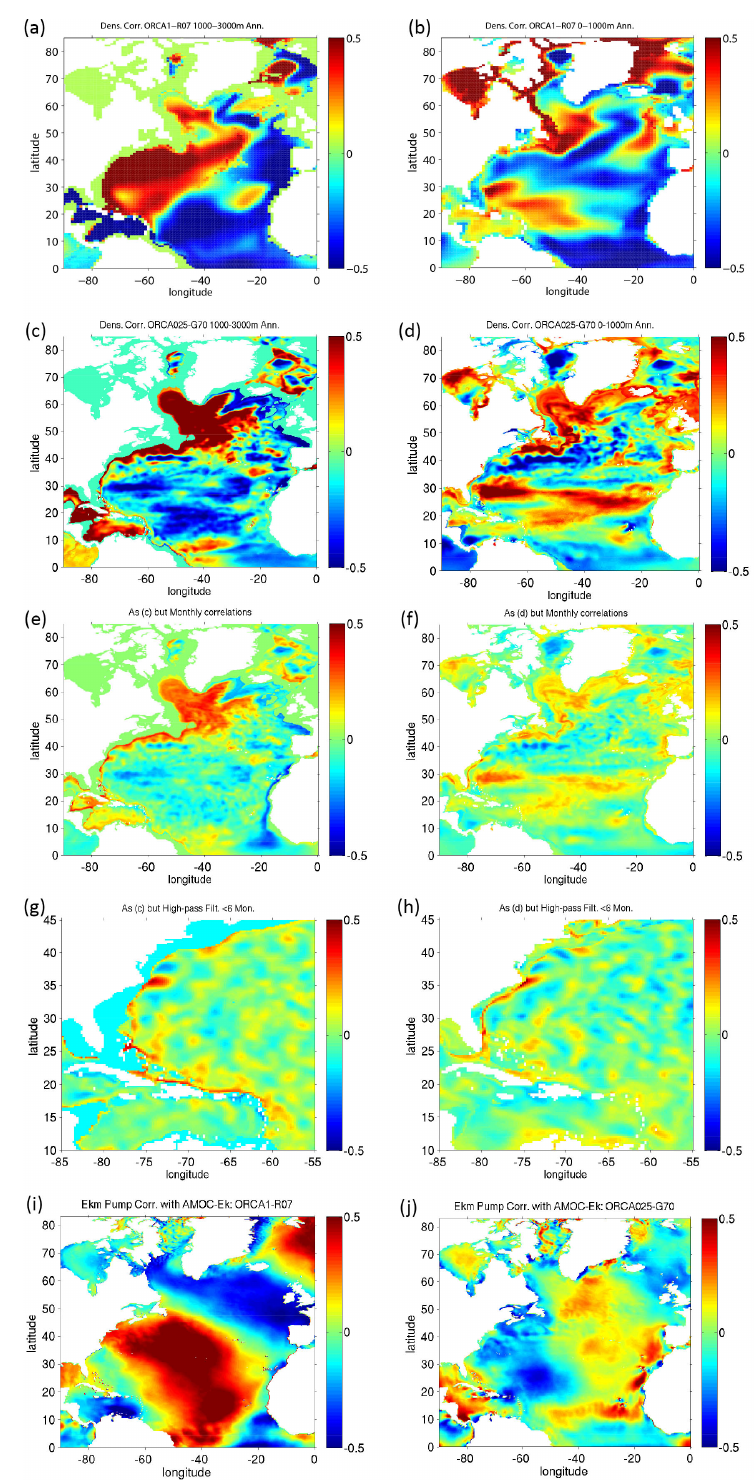
Figure 2. Correlations of the annual AMOC-Ek at 26.5 ◦ N with the 1000–3000m (a, c) and the top 1000m (b, d) averaged density anomalies in ORCA1-R07 (a, b) and ORCA025-G70 (c, d) runs, for the 45-year period 1960–2004 inclusive. (e, f) and (g, h) : the same as (c, d) but calculated from monthly data and data after high-pass filtering with periods shorter than 6 months, respectively; (g, h) are shown in enlarged scale and the colour bar scales are the same as in (e, f) . Annual correlations of Ekman pumping with the AMOC-Ek at 26.5 ◦ N in ORCA1- R07 (i) and ORCA025-G70 (j) , for the 45-year period 1960–2004 inclusive. Multi-annual timescales are removed by filtering out periods longer than 12